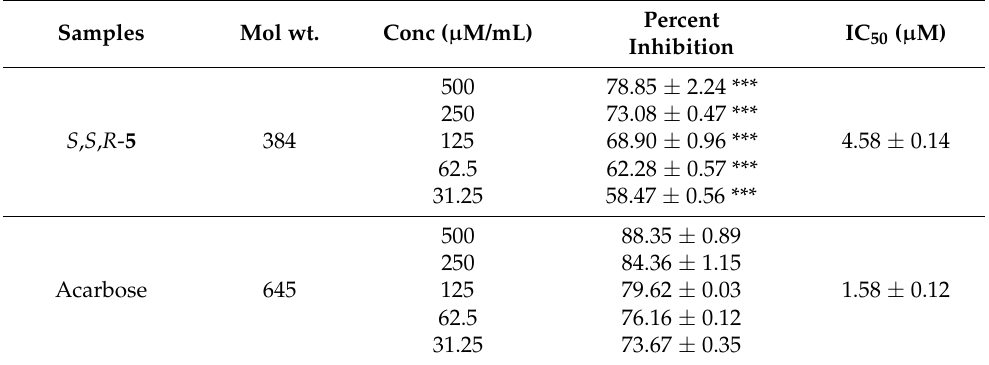
Table 3. Alpha amylase inhibitory results of S , S , R - 5 . Samples